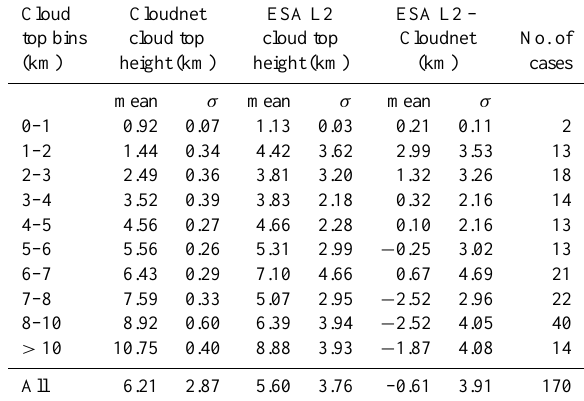
Table A6. Comparison of SCIAMACHY ESA L2 cloud top height with Cloudnet cloud top height for multilayer clouds.